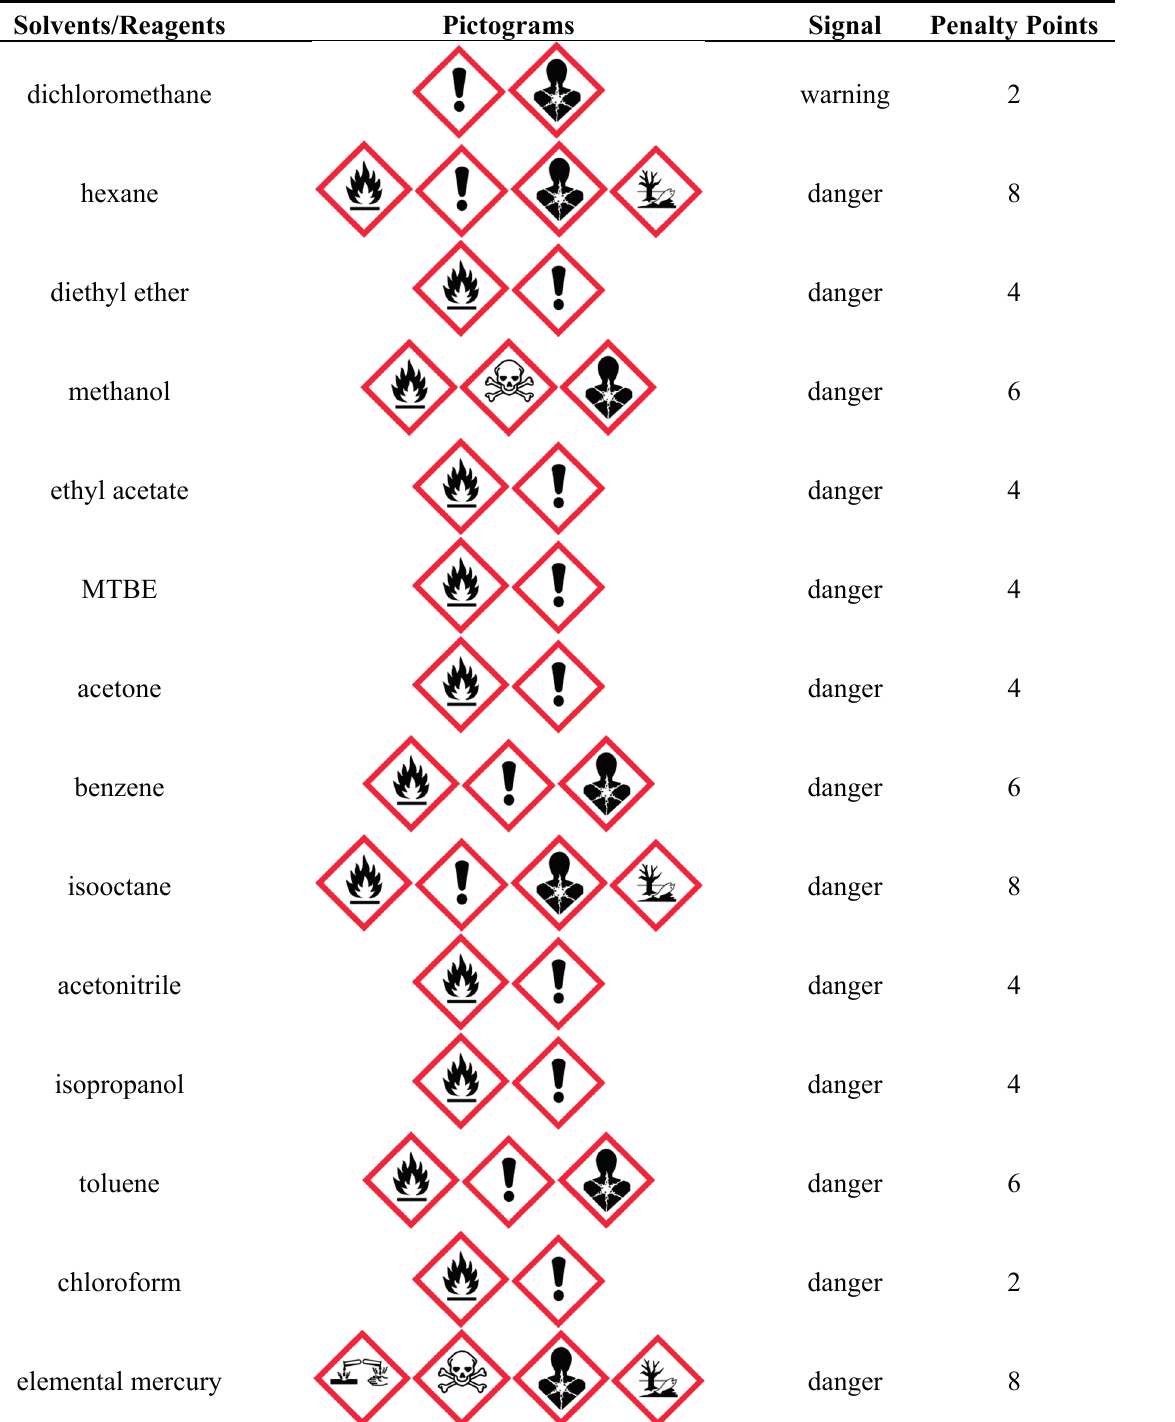
Table 4. The penalty points for selected analytical solvents and